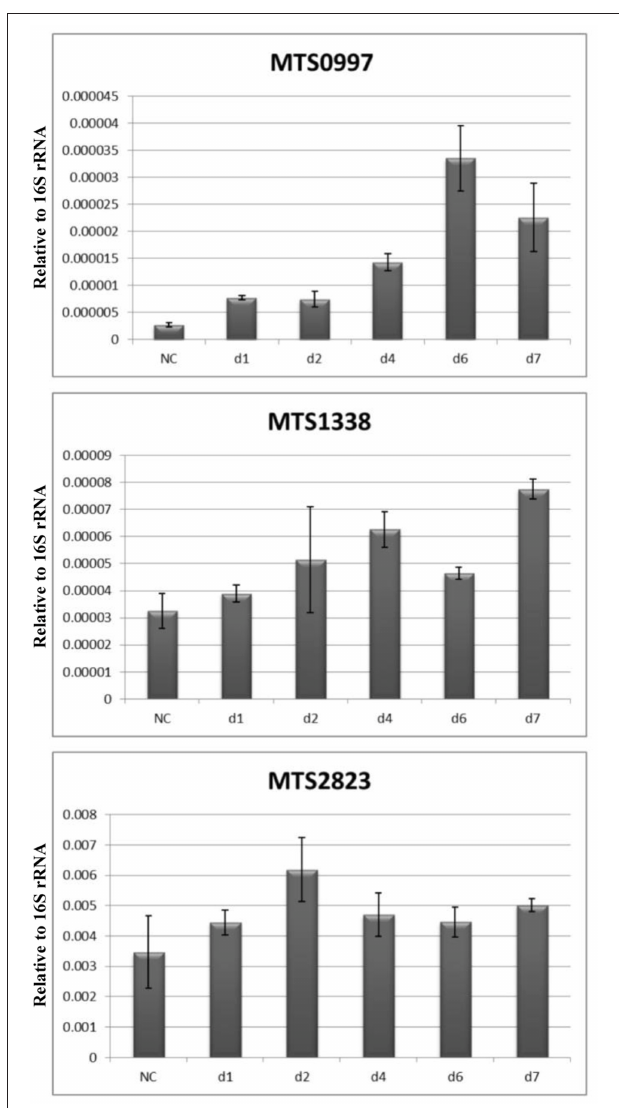
FIGURE 6 | Dynamics of ncRNAs expression during resuscitation. qPCR data are normalized to 16S rRNA transcription level.